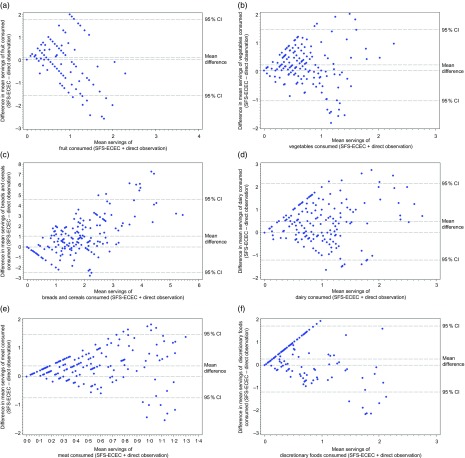
Bland–Altman plots showing agreement between consumption of servings for each food group calculated by Short Food Survey–Early Childhood Education and Care (SFS-ECEC) and direct observations for the following food groups: (a) fruit, (b) vegetables, (c) breads and cereals, (d) dairy/dairy alternatives, (e) meat/meat alternatives and (f) discretionary foods. For each food group, the mean difference in servings between SFS-ECEC and direct observations (y axis) was plotted against the mean servings calculated by SFS-ECEC and direct observations (x axis), including mean differences and 95 % CIs